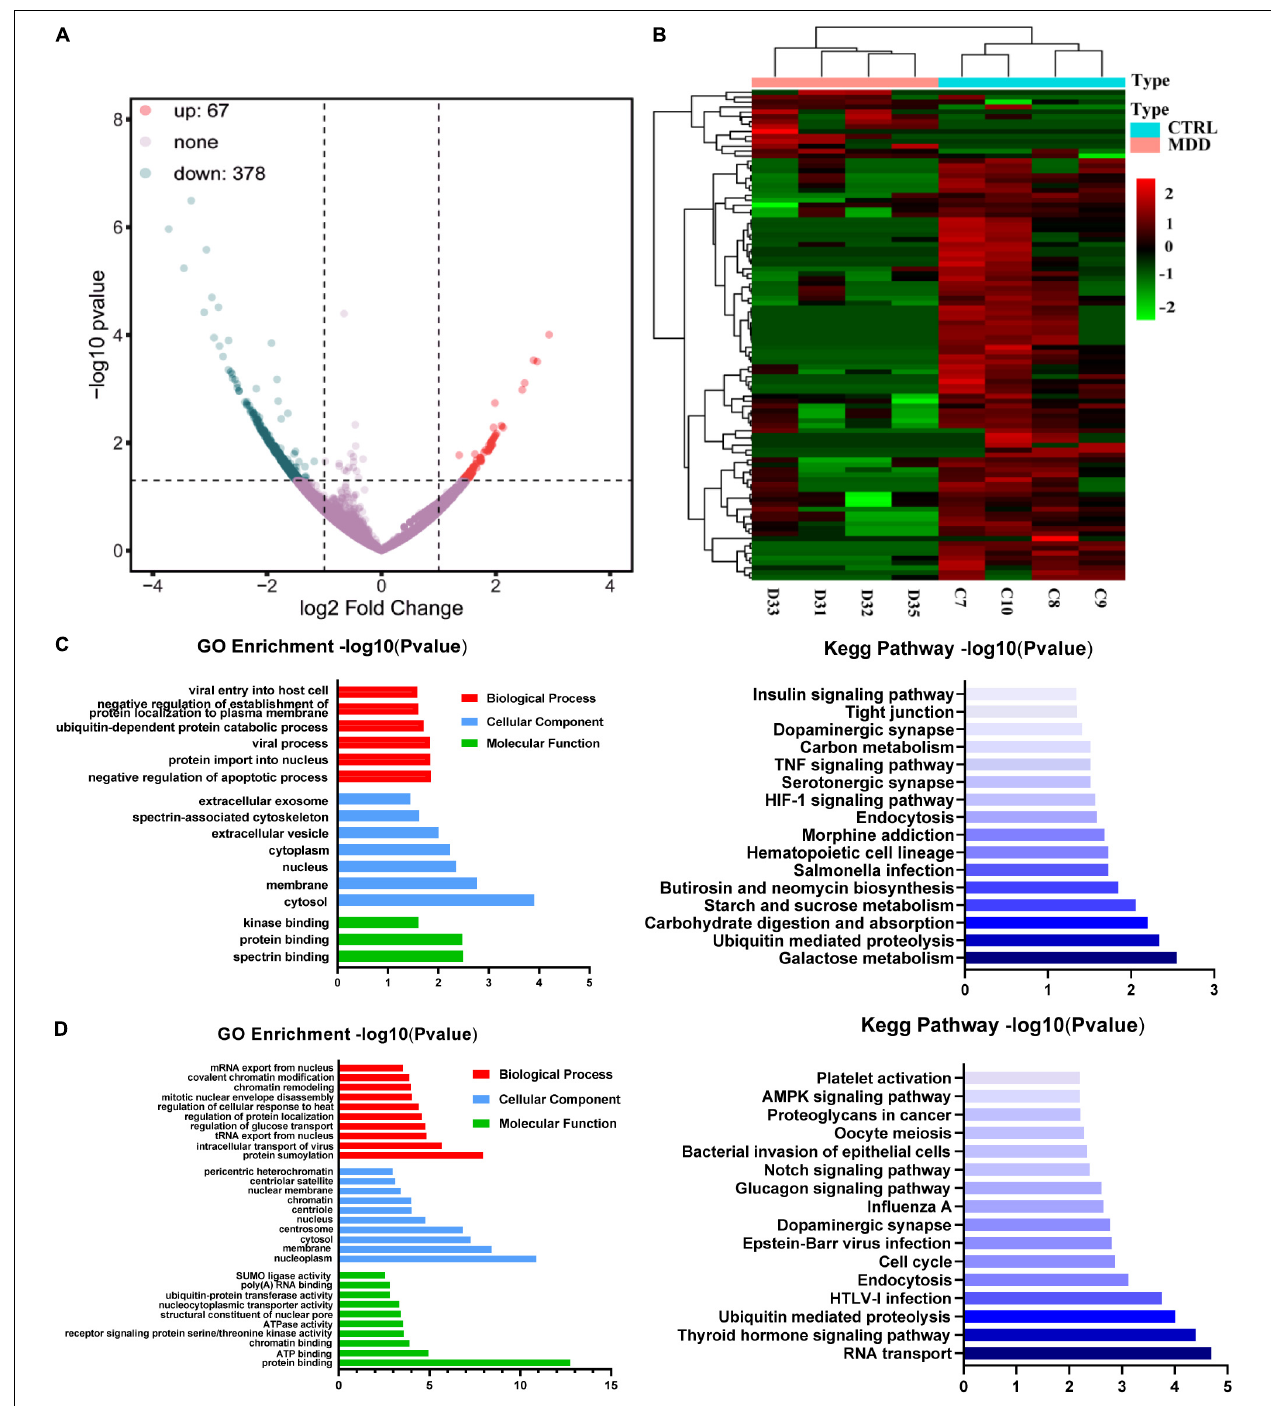
FIGURE 1 | CircRNA expression profiles. (A) Volcano plot of dysregulated circRNAs between 4 MDD patients and 4 healthy controls. (B) Heatmap of top 100 dysregulated circRNAs between 4 MDD patients and 4 healthy. (C) GO and KEGG enrichment analyses based on upregulated circRNAs in MDD patients. (D) GO and KEGG enrichment analyses based on downregulated circRNAs in MDD patients.